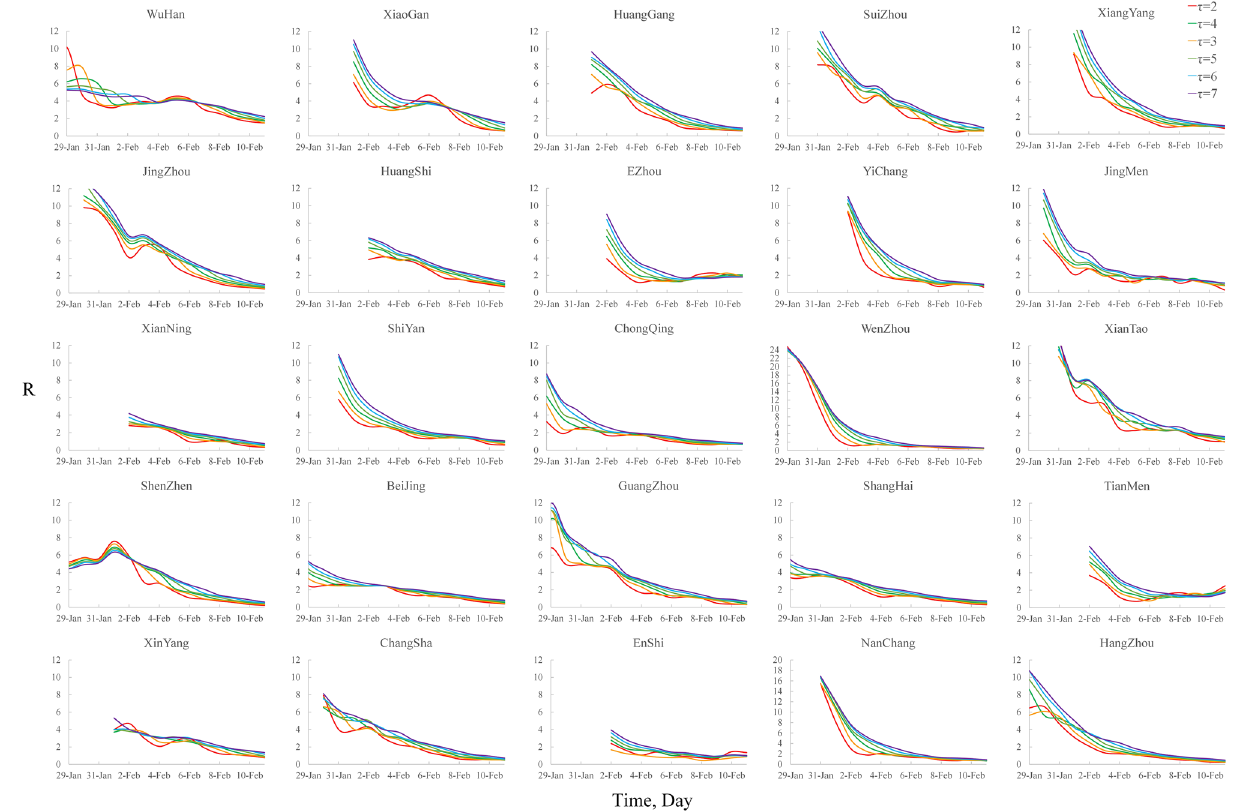
Figure 7. R estimation for 25 cities based on different time windows ( τ = 2, 3, 4, 5, 6, or